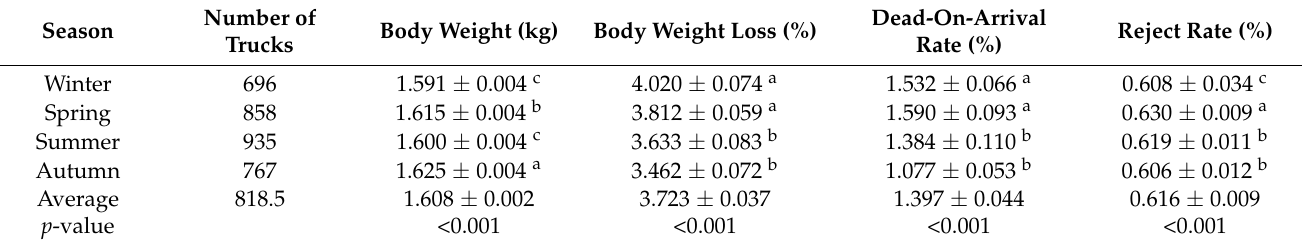
Table 2. Average body weight, body weight loss, dead-on-arrival rate, and reject rate according to seasons (mean ± SEM).